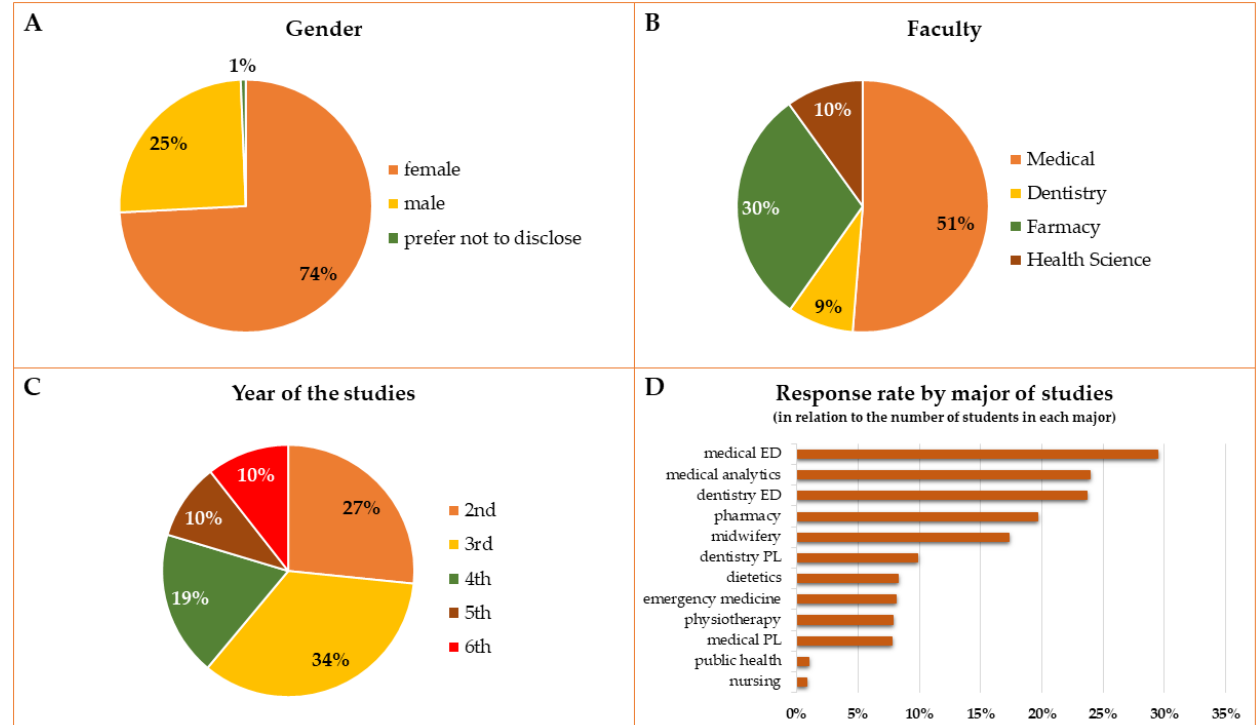
Figure 1. General description of the respondents. Gender ( A ), Faculty—Medical and Dentistry